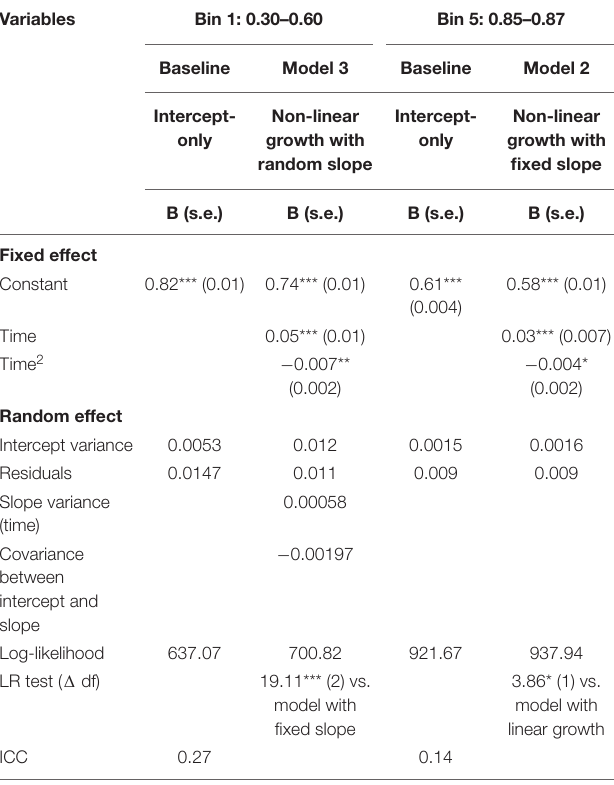
TABLE 8 | Cohort 1: results of ME growth models for changes in ANS accuracy for the easiest (0.30–0.60) and hardest (0.85–0.87) ratio bins from grade 1 to grade 5. Variables